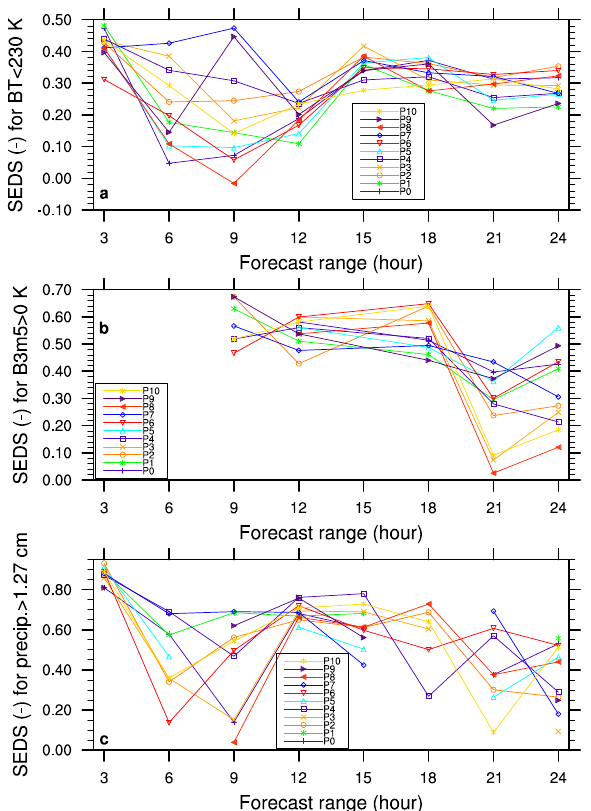
Fig. 11. Time series of SEDS for (a) 10.8 µ m BT less than 230 K, (b) B3m5 larger than 0 K and (c) 3-h accumulated precipitation greater than 1.27cm. SEDS scores were calculated over the domain shown in Fig. 8.